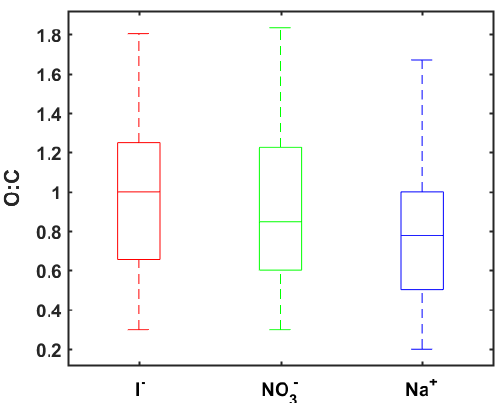
Figure 11. Box plots showing the 5th, 25th, 50th, 75th, and 95th percentiles for the O:C ratio of monomeric products from α -pinene ozonolysis detected in different ion